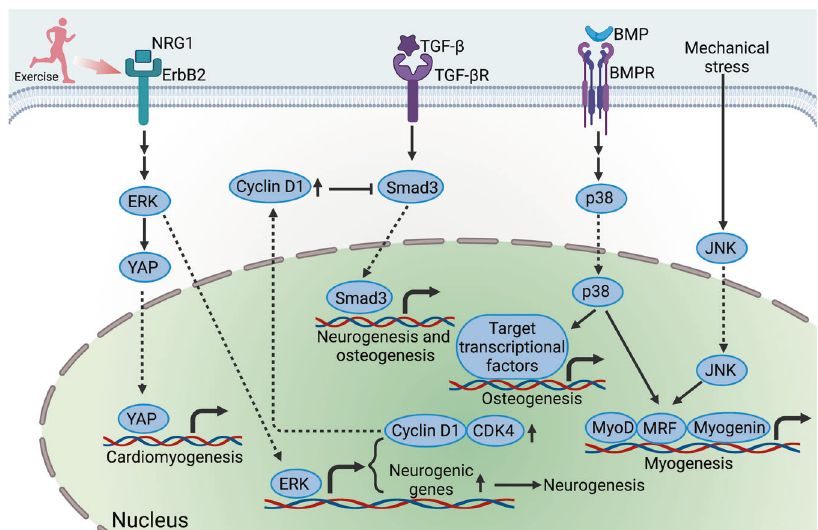
Fig. 4 MAPK signaling pathway. The MAPKs signaling can be activated by exercise-induced mechanical stress and a range of growth factors, including NRG1, TGF- β and BMP, thus playing an important role in exercise-induced tissue regeneration. MAPK/ERK signaling activates YAP translocation into nucleus, promoting cardiomyogenesis. The activation of ERK also promotes neurogenesis and cycling of satellite cells. The restoration of cyclin D1 inhibits TGF- β /Smad signaling. The p38 MAPK and JNK can activate the transcription factors that initiate the expression of osteogenetic and myogenetic genes, including Myod, MRF, and Myogenin, promoting osteogenesis and myogenesis. Created with